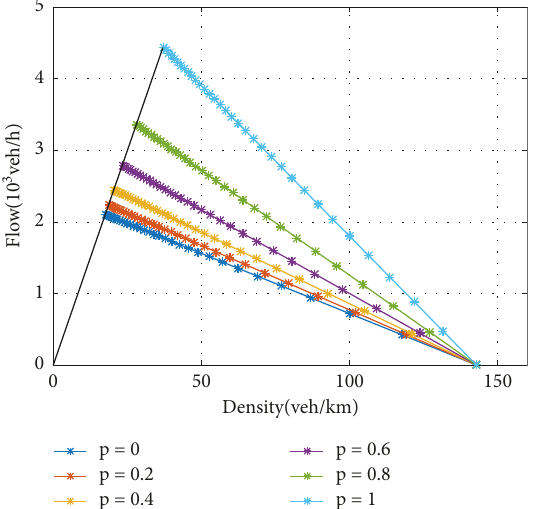
Figure 4: Fundamental diagram of mixed traffic flow under dif- ferent CAVs penetration